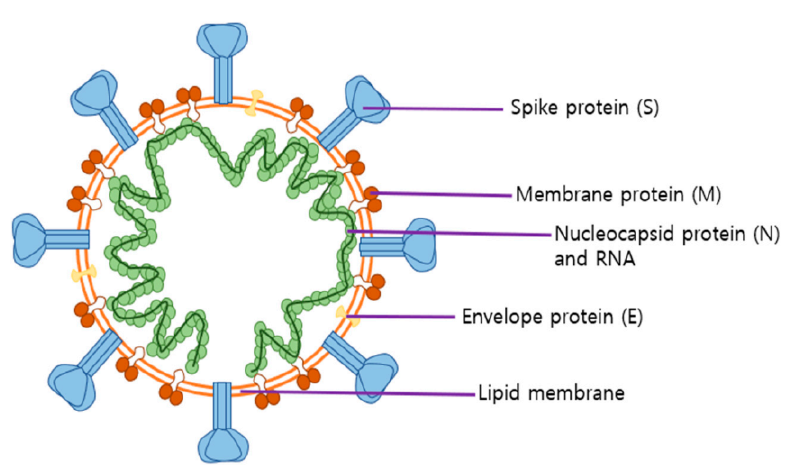
Figure 1. Roles of severe acute respiratory syndrome coronavirus 2 (SARS-CoV-2) structural proteins. The spike protein (S), which provides the crown shape, mediates the binding of the virus to the host’s angiotensin-converting enzyme 2 (ACE2) receptors and determines its affinity for the host. The nucleocapsid protein (N), which encloses the viral genome, is known to regulate transcription and immunoreaction. The membrane protein (M), which is the most common structural protein, seems to be involved in viral assembly and maturation. The envelope protein (E), which is the smallest structural protein, functions as an ion channel and assists in viral assembly and